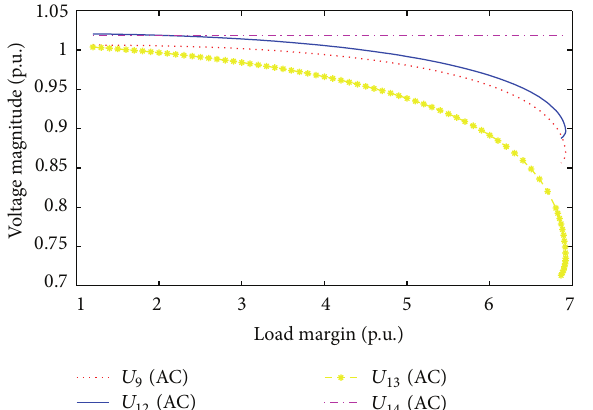
Figure 5: PV curves for modified IEEE-14 bus system in operating mode “2.”